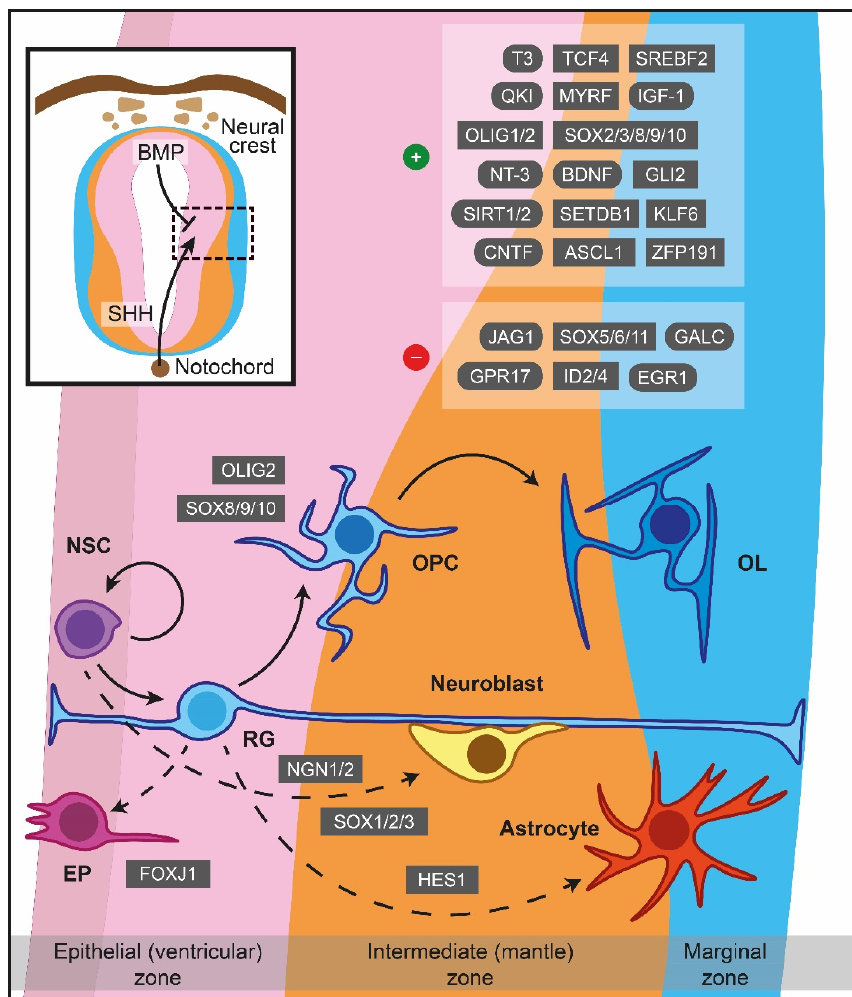
Figure 1. Major cues of OPCs generation and differentiation during myelinogenesis in the prenatal period. In the neuroepithelium lining the neural tube, NSCs are under the influence of notochord- derived SHH, which drives the cells to become OPCs through OLIG2, SOX8/9/10 or follow neuronal fate (neuroblasts) via NGN1/2 and SOX1/2/3. BMP originated from the neural crest instructing NSCs to become astrocytes, controlled by HES1 as well. FOXJ1 is a crucial transcription factor for the ependymal trajectory. The positive and negative cues controlling OPCs differentiation are displayed in the upper right boxes. The hatched box depicts a representative area around sulcus limitans (between alar and basal plates). Dashed lines showcase naturally occurring processes, albeit not addressed in detail in the current review. ASCL1: Achaete-scute family bHLH transcription factor 1, BDNF: Brain-derived neurotrophic factor, BMP: Bone morphogenetic protein, CNTF: